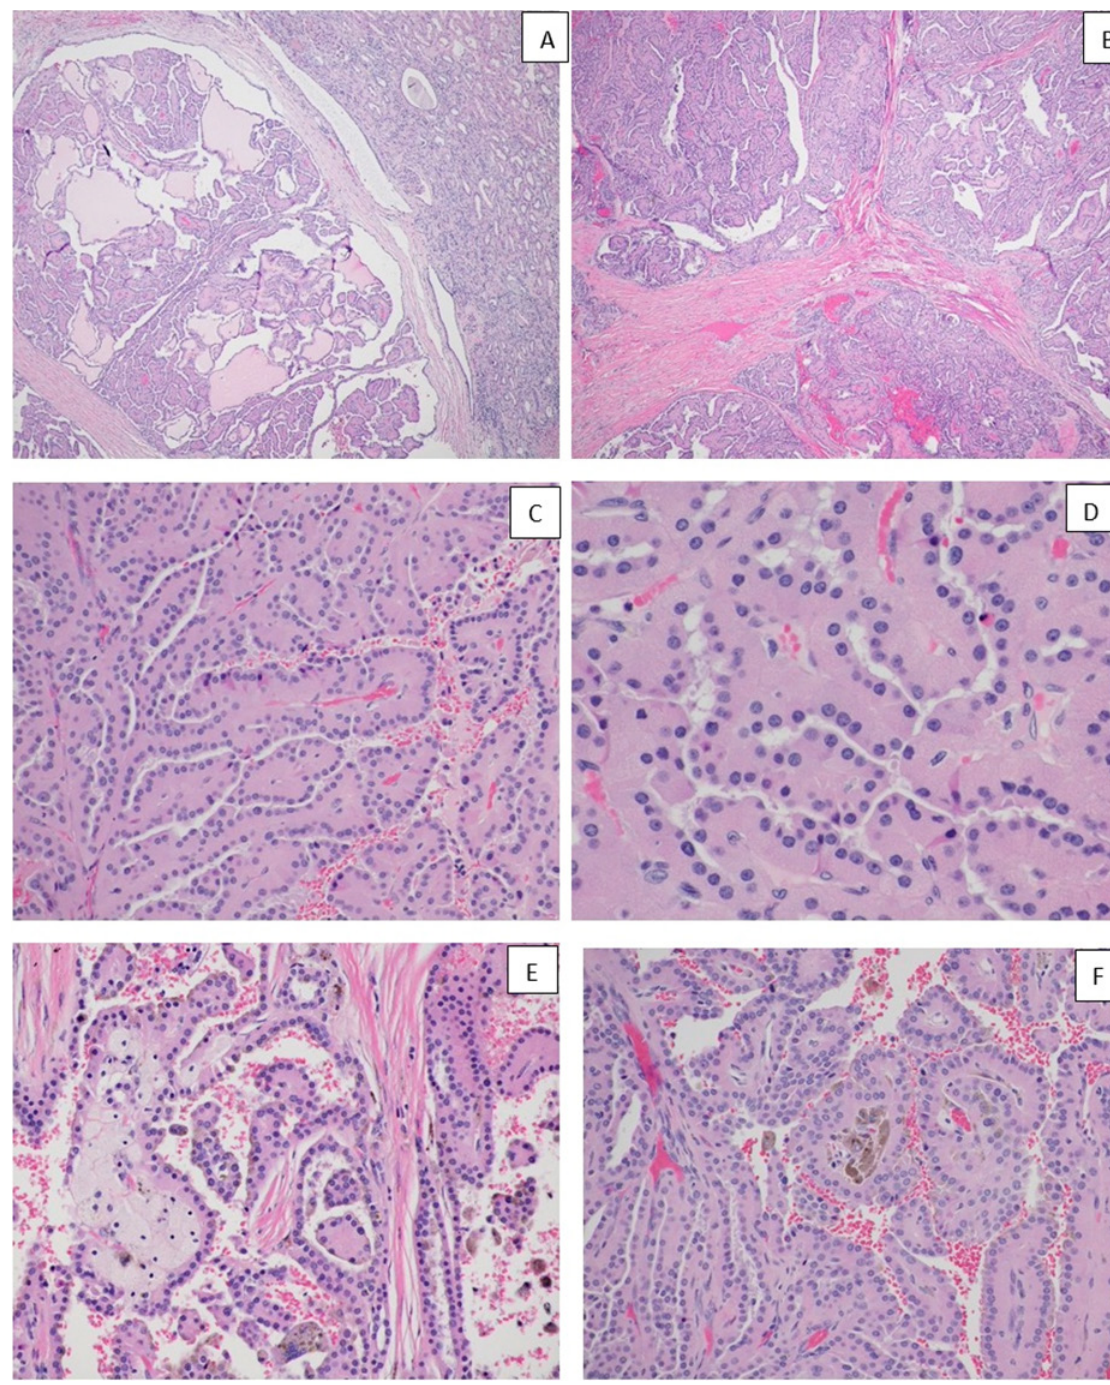
Figure 3: Hematoxylin- and eosin-stained sections of the renal tumor (A). Low magnification showing a well-circumscribed tumor with papillary structures and normal kidney on the right (×40) (B). Well-circumscribed papillary tumor with fibrous septa separating the tumor (×40) (C). Papillary architecture of the tumor with thin fibrovascular core (×100) (D). The tumor cells have abundant granular eosinophilic cytoplasm and a round nucleus placed away from the basal lamina (×400) (E). Papillary tumor with foamy histiocytes (×200) and F. Papillary tumor with hemosiderin pigment (×200)